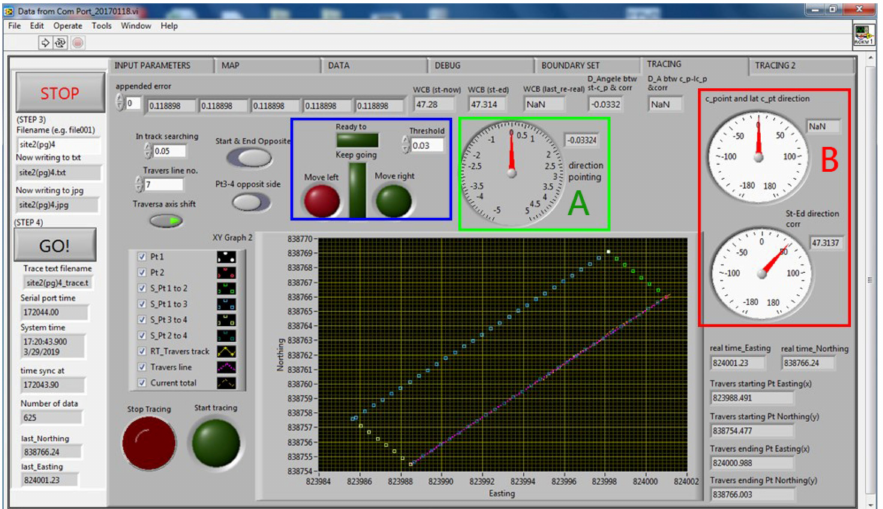
Figure 5. Interface of the guidance system (blue box: first method distance offset; green box: second method of WCB comparison; red box: third method direction